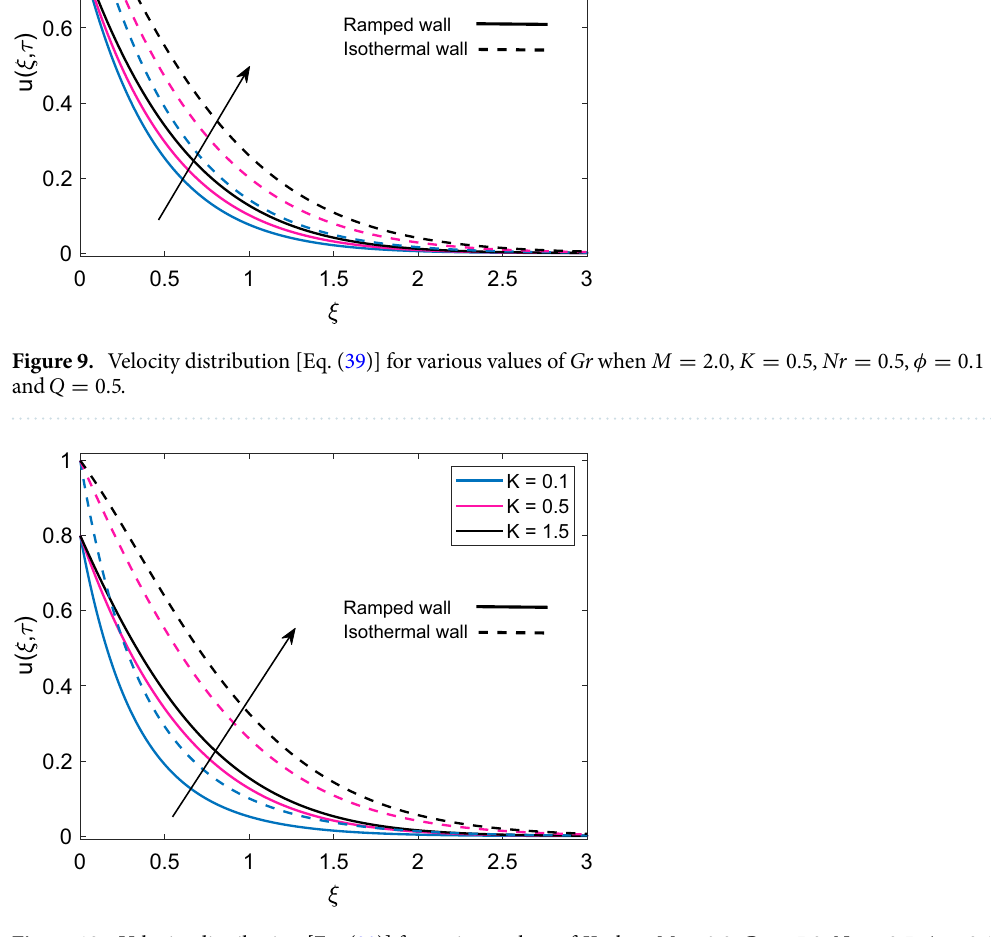
Figure 10. Velocity distribution [Eq. (39)] for various values of K when M = 2.0 , Gr = 5.0 , Nr = 0.5 , φ = 0.1 and Q = 0.5